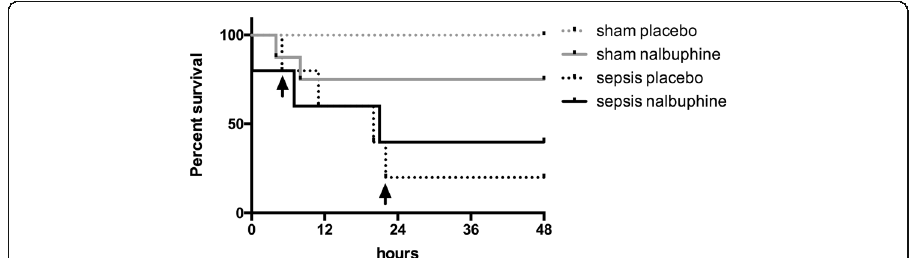
Fig. 4 Survival curve of long-term experiments (48 h). Survival of long term experiments (48-h observation). Arrows indicate termination of experiments in the sepsis placebo group due to high clinical scoring